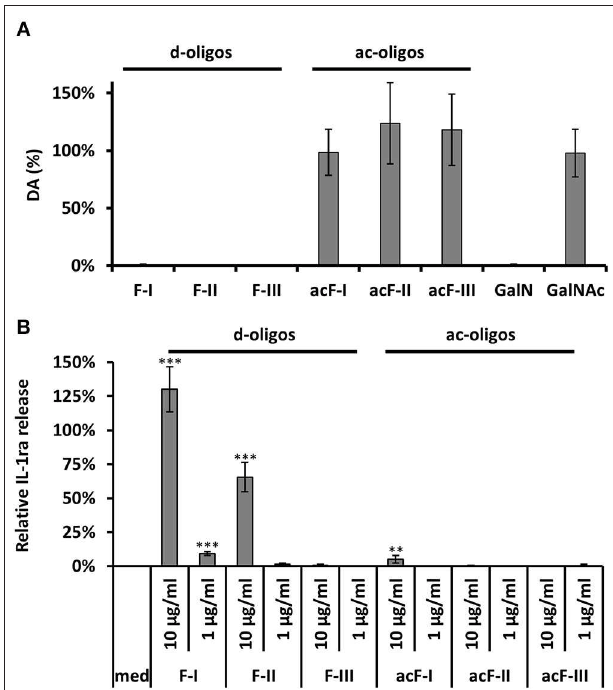
FIGURE 4 | N -acetylation of de- N -acetylated GAG oligosaccharides and its impact on the IL-1Ra production. (A) Determination of the degree of acetylation (DA) by acetate assay of de- N -acetylated and acetylated fractions I, II and III. GalN and GalNAc served as positive and negative controls. (B) In vitro IL-1Ra production by de- N -acetylated and acetylated GAG fractions I, II, and III (10 and 1 µ g/ml). LPS (10ng/ml) served as positive control. WMW Test: ** p < 0.01,*** p <